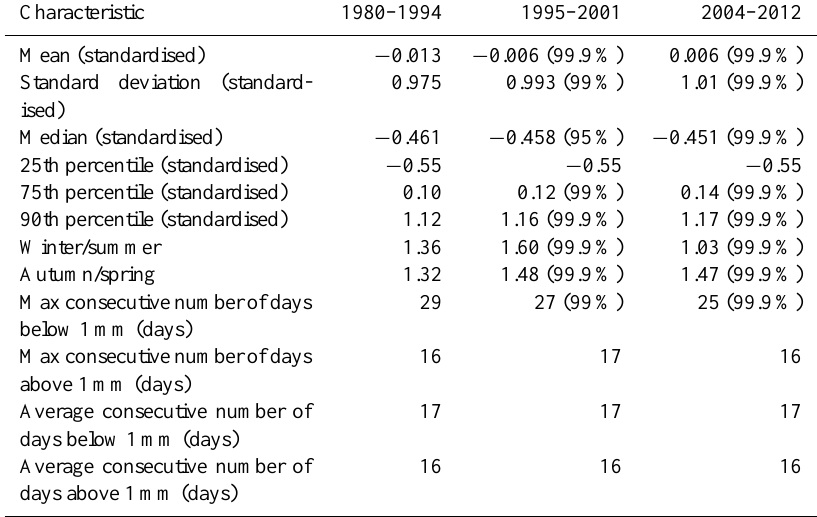
Table 2. Change in the median value of the potential driving characteristics for 1995–2001 and 2004–2012, compared to 1980–1994. The median value (taken from all the 91 catchments) is presented along with the significance level (if significantly different from 1980 to 1994 at or above the 95% CI).